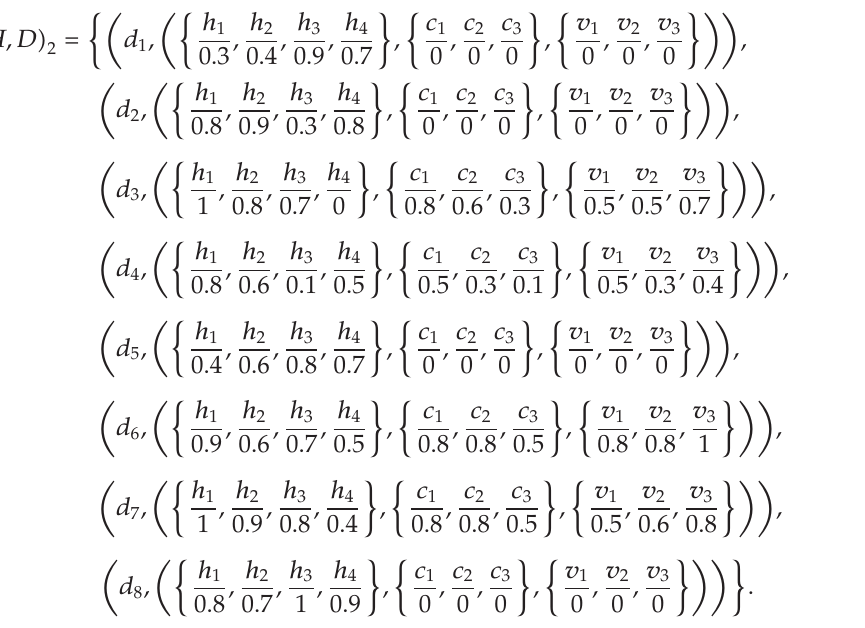
(cid:5) H,D (cid:6) 1